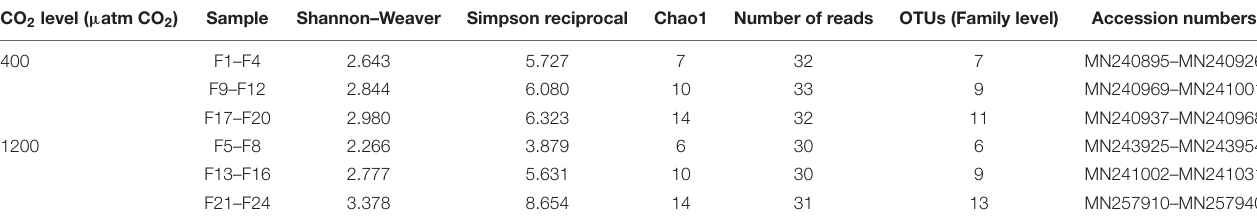
TABLE 2 | Alpha diversity estimates through the determination of diversity indexes of the microbiota of the intestinal fluid of Sparus aurata. CO 2 level ( µ atm CO 2 )